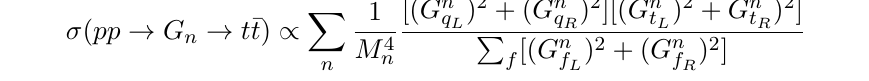
; c (cid:22) ) coming from the searches of massive reso- L L ;(cid:28) L = 0 : 8, c (cid:22) = 0 : 65, c (cid:28) = 0 : 55, c b = 0 : 2, c b = 0 : 55 and R R R L R = 0 : 1, and in the right panel c (cid:22) = 0 : L L